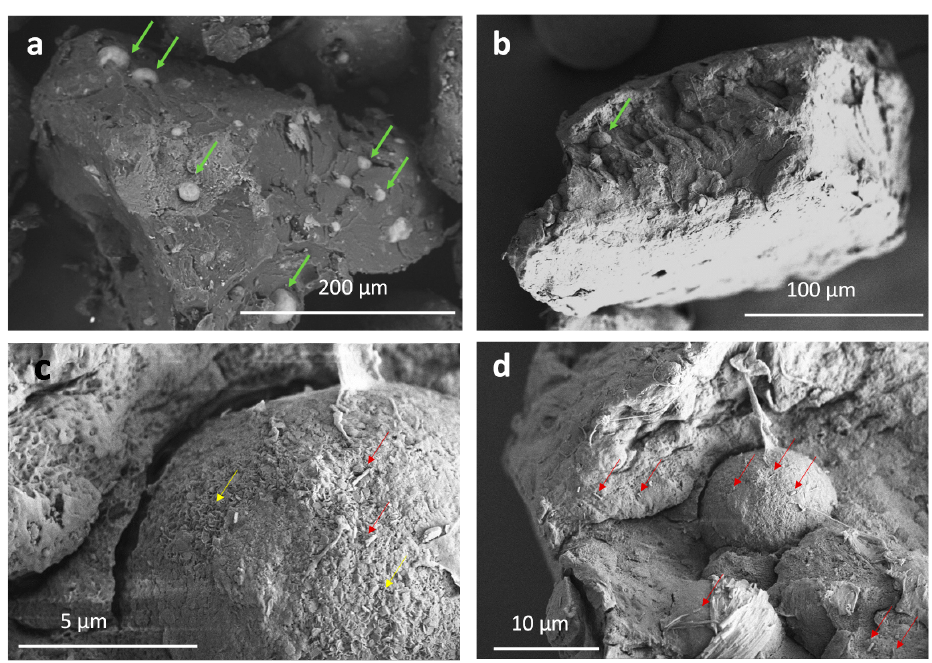
Figure 3. Micrographs of G-10Mg granules at different magnifications, highlighting ( a , b ) Mg particles (green arrows), ( c , d ) HNT–SrR (red arrows) and ( c ) the formation of MgO/Mg(OH) 2 nanoplatelets (yellow arrows).